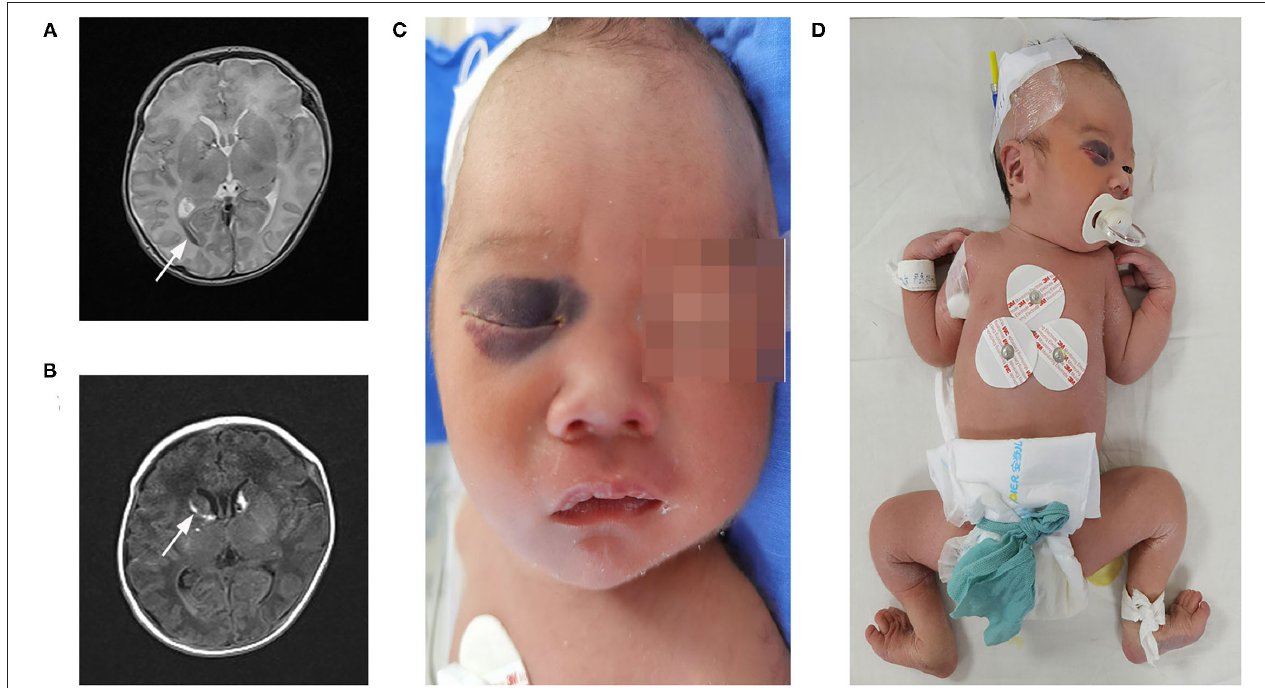
FIGURE 2 | Clinical features and imaging manifestations of proband. (A,B) Cranial MRI: intraventricular hemorrhage and subarachnoid hemorrhage (direction of arrow). (C) Facial bruises. (D) Wrist, excessive abduction of the bilateral hip joints, bipedal valgus, and excessive flexion.